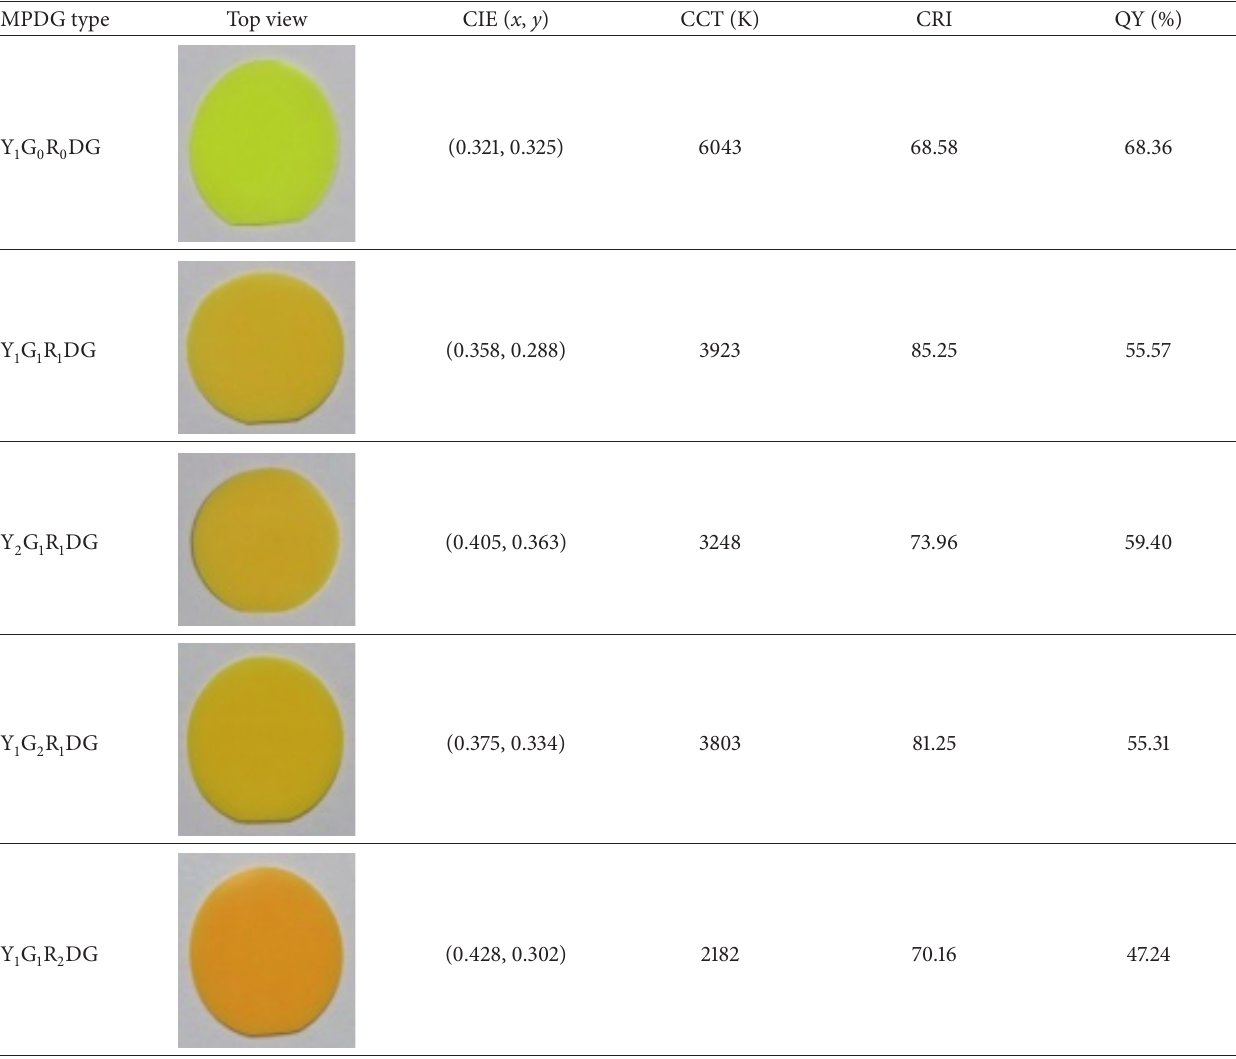
Table 2: Optical properties of MPDG based WLED.